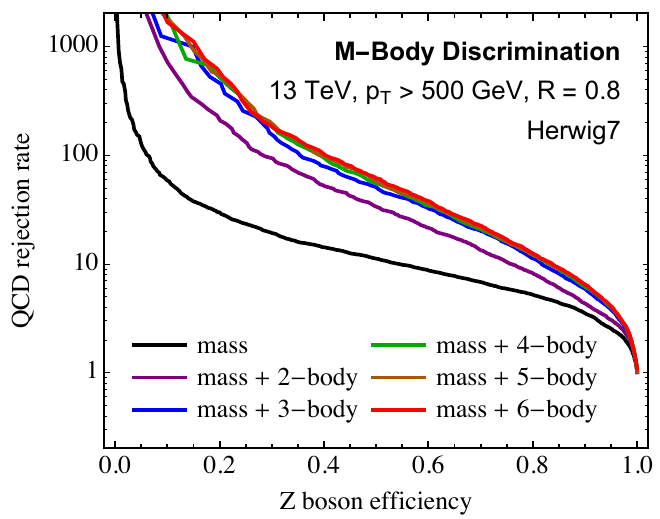
Figure 10. Z boson jet e(cid:14)ciency vs. QCD jet rejection rate plot generated by the deep neural network for jets showered in Herwig. The di(cid:11)erent curves correspond to the mass plus collections of N -subjettiness observables that uniquely de(cid:12)ne M -body phase space. Discrimination power is seen to saturate when 3- or 4-body phase space is